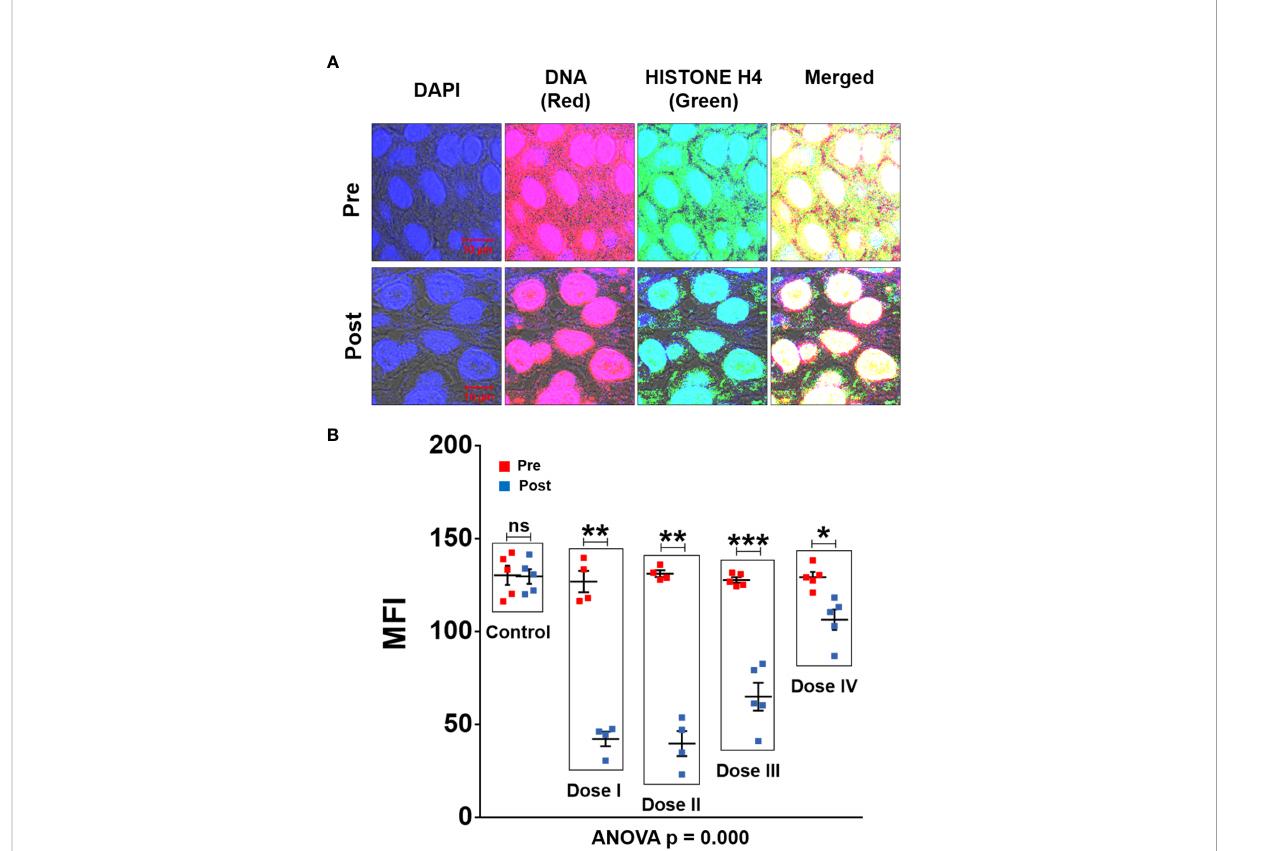
fl uorescence images, a profusion of cfCh particles in the form of yellow fl uorescent signals is seen in TME. Yellow cfCh signals were markedly reduced following R-Cu treatment. (B) Quantitative analysis of MFI of yellow fl uorescent signals representing C-cfChPs in fi ve randomly chosen confocal fi elds (~50 cells per fi eld). Combined statistical comparison of pre versus post treatment values of all four treatment groups with the control group was done using two-way ANOVA; p values of which are given under the graph. Comparison of pre versus post treatment